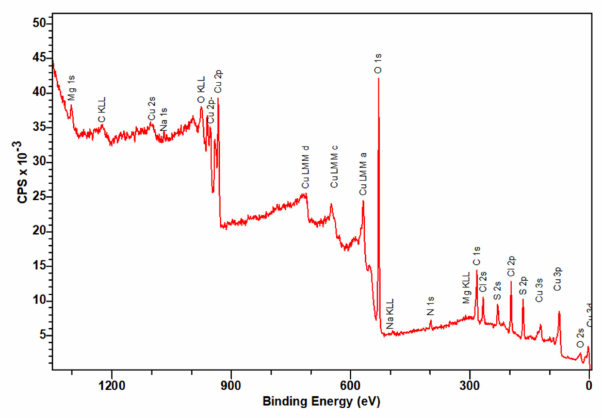
Figure 6. XPS survey scan of CuCys-CD.